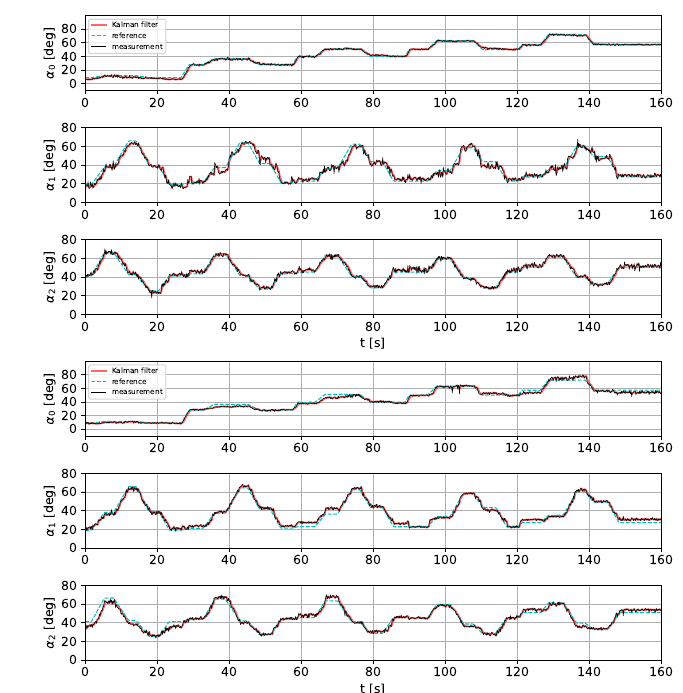
Figure 12. Comparison of the angle prediction accuracy for graph fitting and sparse CNN on the testing data set, learned on the image from the right